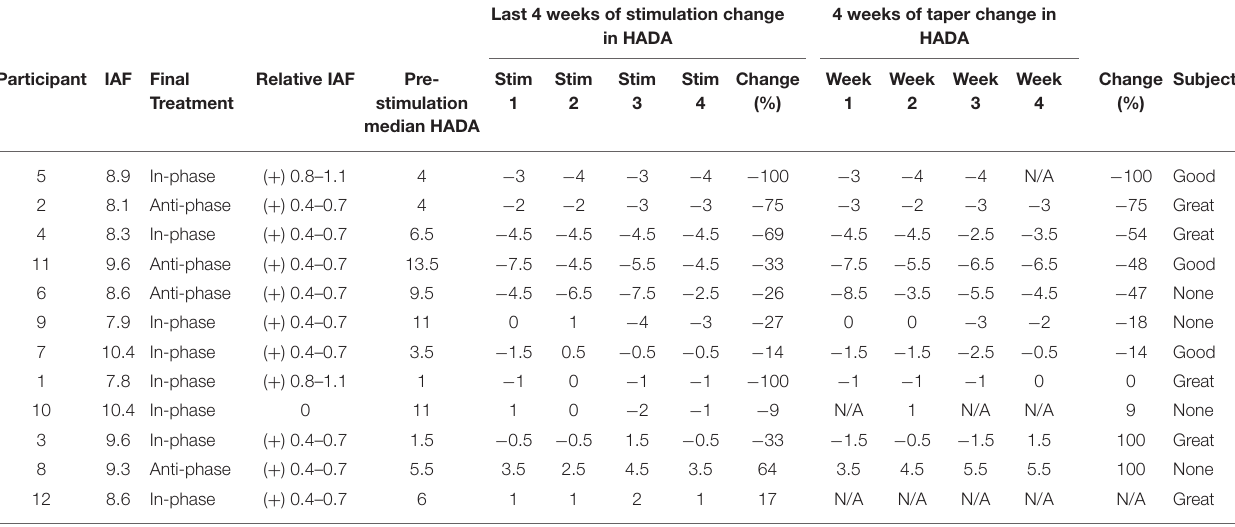
TABLE 3D | Hospital anxiety depression scale-anxiety subscale (HADA).